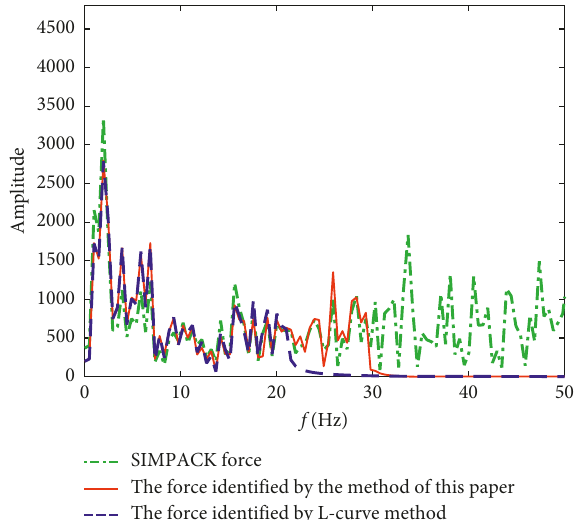
Figure 35: Amplitude-frequency curve of the two methods for F identification when the noise level is 5%. 2